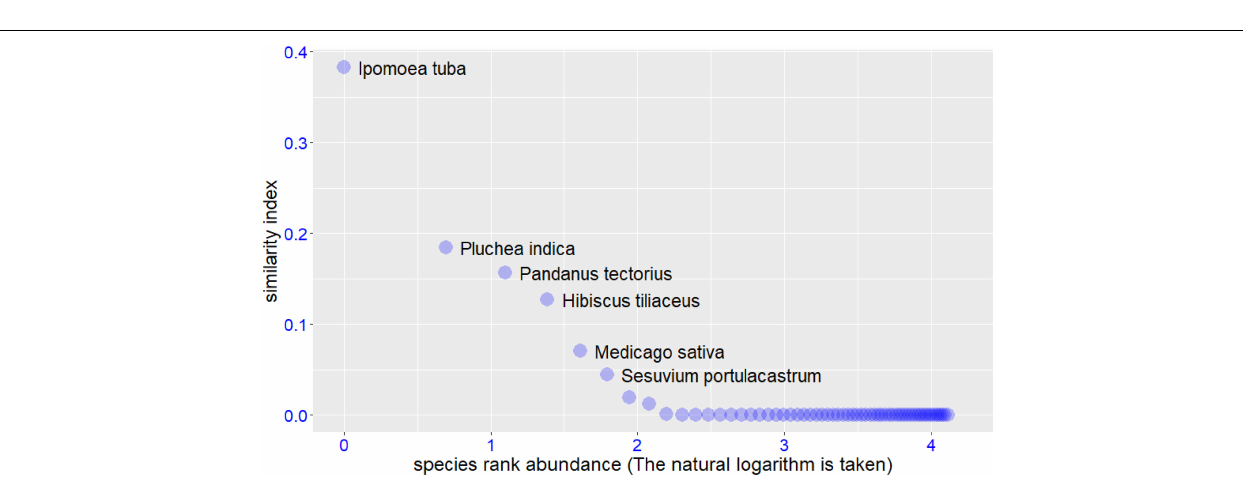
FIGURE 2 | Species selection results for the target species Scaevola sericea . The similarity index used in this study are relative abundances which output from the Maxent model.